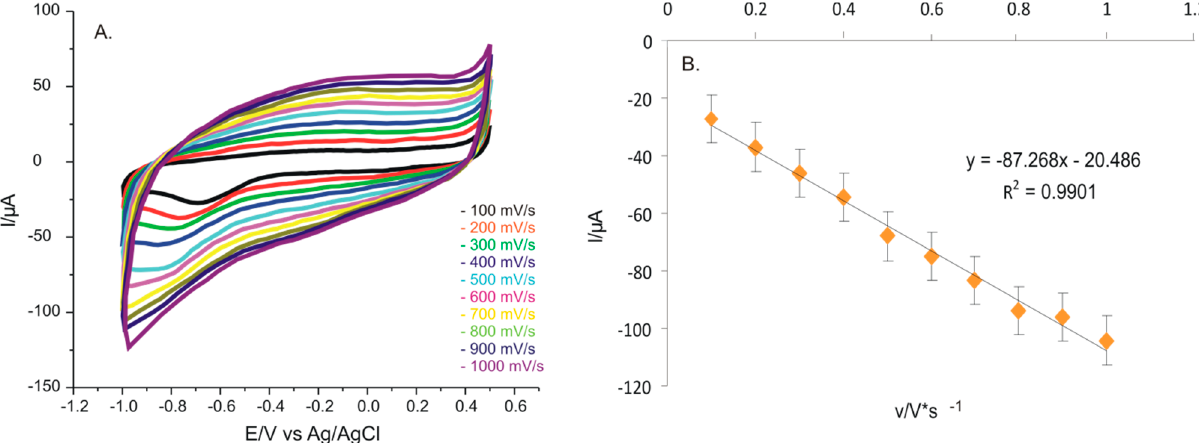
Figure 7. ( A ) CVs of PPy/FeCN/SPCE sensor immersed in a 0.1 M KCl and 10 − 3 M L-TRP solution at scan rates between 0.1 and 1.0 V × s − 1 . ( B ) The plot of the linear dependence between I pc and the scan rate.